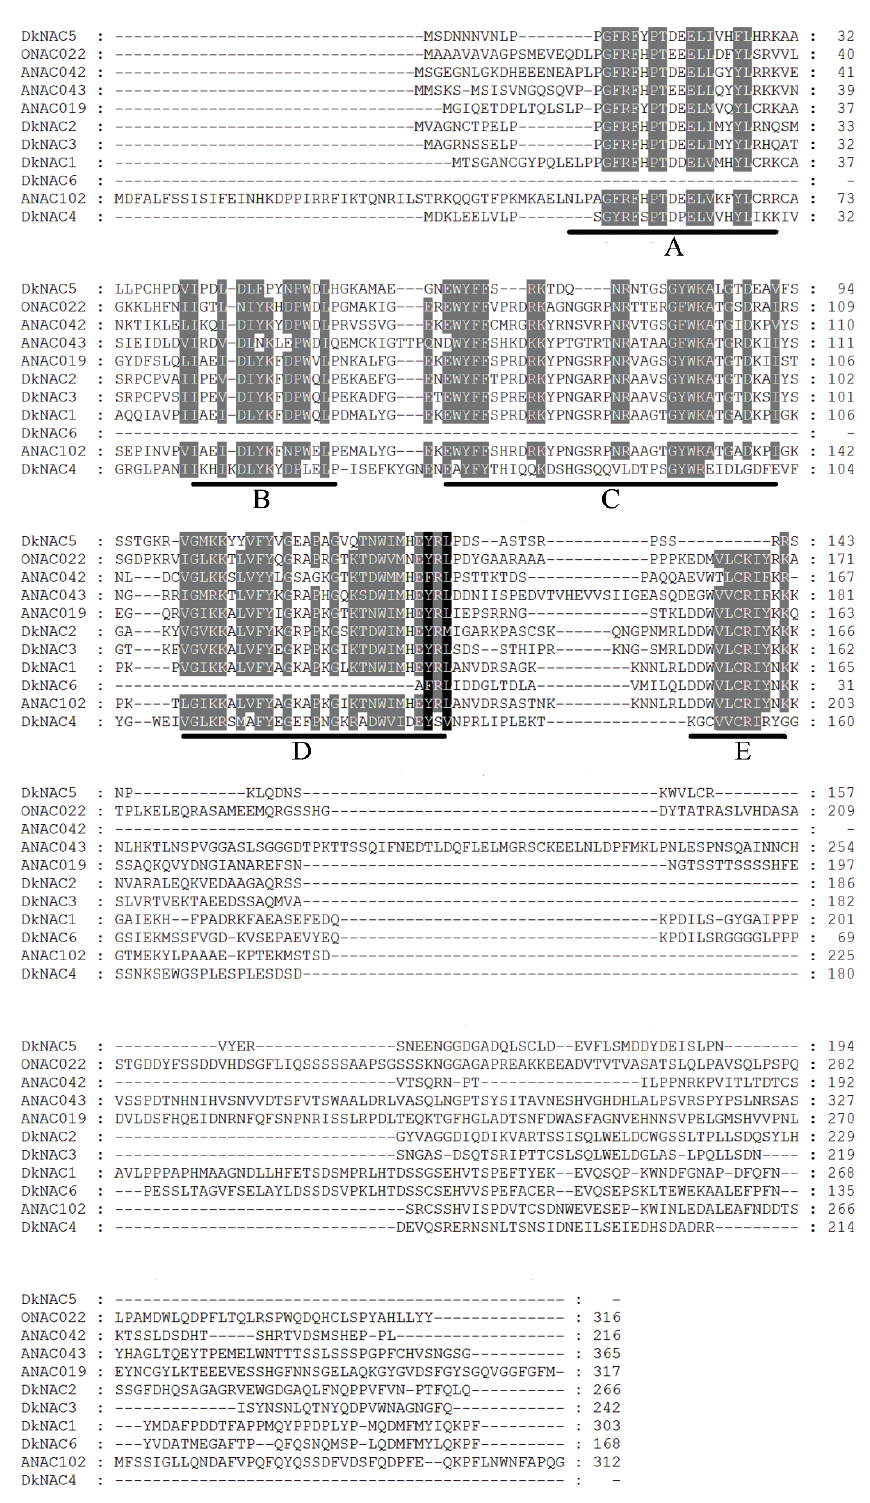
Figure 4. Amino acid sequence alignment of the DkNAC proteins with Arabidopsis and rice NAC proteins. DkNAC proteins were aligned with Arabidopsis ANAC019 (At1g52890.1), ANAC042 (At2g43000.1), ANAC043 (At2g46770.1), ANAC102 (AT5G63790.1) and rice ONAC022 (AK107090). Identical and similar amino acids are indicated by black and grey shading, respectively. Gaps were introduced to optimize alignment. The five highly conserved amino acid motifs ( A – E ) are indicated by black